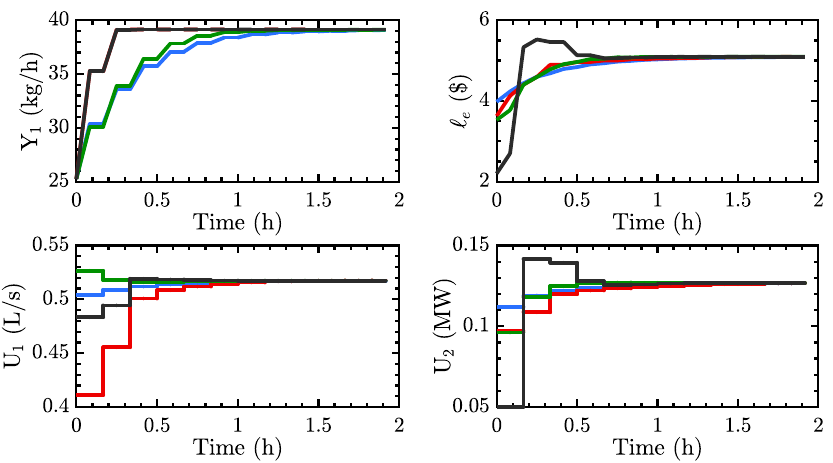
Figure 5. Closed-loop trajectories of EMPC and different MPC tuning parameters starting from a lower economic cost to a higher one. EMPC (blue), MPC I (red), MPC II (green), MPC III (black). The average economic performances are 3.654, 3.668, 3.650, 3.685 for EMPC, MPC I, MPC II, MPC III, respectively; ( top-left ) mass flow rate of CO 2 in the treated flue gas; ( top-right ) economic performance of controller; ( bottom-left ) volumetric flow rate of solvent; ( bottom-right ) heat input to reboiler.